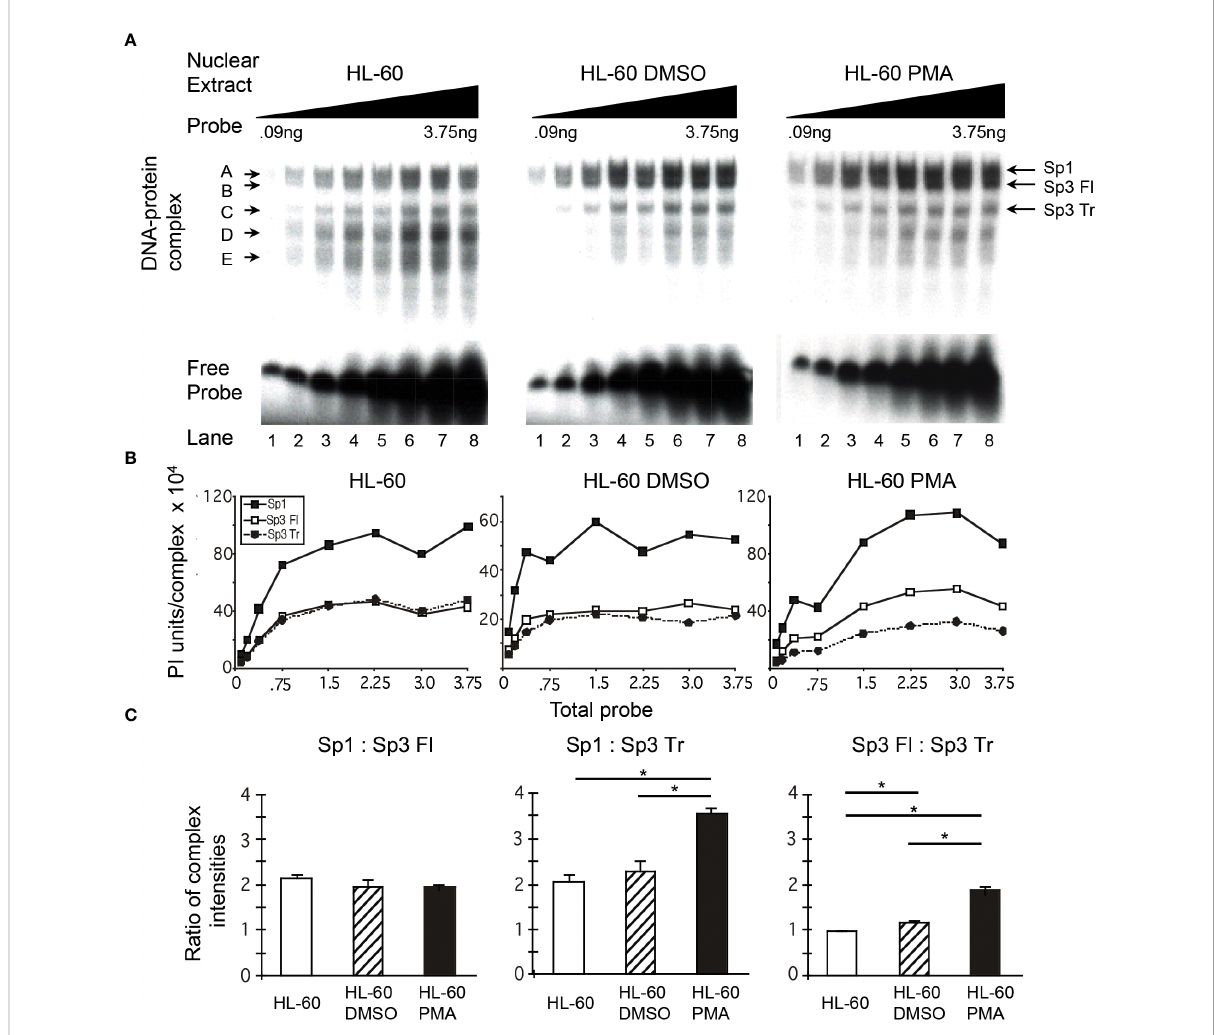
FIGURE 3 Relative levels of Sp factor binding in the myleomonocytic HL-60 cell line are altered with the addition of the chemical differentiating agent, PMA. Relative Sp factor binding was examined by EMS probe titration analyses. (A) Untreated, DMSO-treated, and PMA-treated HL-60 nuclear extracts (6 m g) were reacted with increasing amounts of labeled HIV-1 Sp site III probe (12,500 to 500,000 cpm; 0.09 to 3.75 ng). Complexes were separated utilizing a 2-hr electrophoresis interval through a 4% acrylamide gel to retain unbound probe and facilitate subsequent analysis. DNA-protein complexes are labeled A through E; arrows indicate the position of low mobility Sp-related complexes. Representative image shown. (B) Untreated, DMSO-treated, and PMA-treated HL-60 nuclear extracts (6 m g) were reacted with increasing amounts of labeled HIV-1 Sp site III probe (12,500 to 500,000 cpm; 0.09 to 3.75 ng). Complexes were subjected to a 3-hr electrophoresis interval utilizing 4% acrylamide to allow for greater separation and a more accurate subsequent quantitation of the resulting DNA-protein complexes. Unbound probe was not retained. DNA-protein complexes were quantitated and graphed as phosphorimager units per complex. Representative graph shown. (C) DNA- protein complexes intensities (B) were averaged at saturation and their relative levels compared within a given gel. This process was repeated three times and the average of the three relative intensities was graphed for each pair of DNA-protein complexes examined: Sp1 relative to full- length Sp3 (Sp3 Fl), Sp1 relative to truncated Sp3 (Sp3 Tr), and Sp3 Fl relative to Sp3 Tr. Comparisons between all were evaluated by the quantitative two-tailed student t-test and p < 0.05 was considered signi fi cant